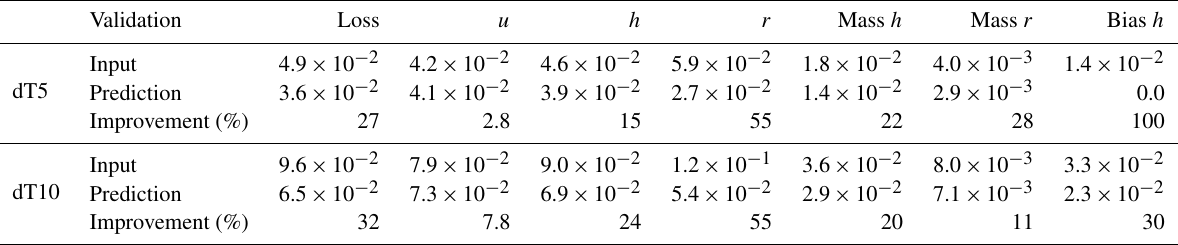
Table 1. The loss function, the mean RMSE of the variables u , h and r , the absolute mass error divided by the number of grid points n for h and r , and the bias of h (columns) calculated for the input X valid (top row) and the CNN prediction (middle row) with respect to the output Y valid for the validation data sets. The last row shows the improvement in the prediction towards the output compared to the input in percentage. The two sections in the table correspond to dT5 and dT10, respectively.